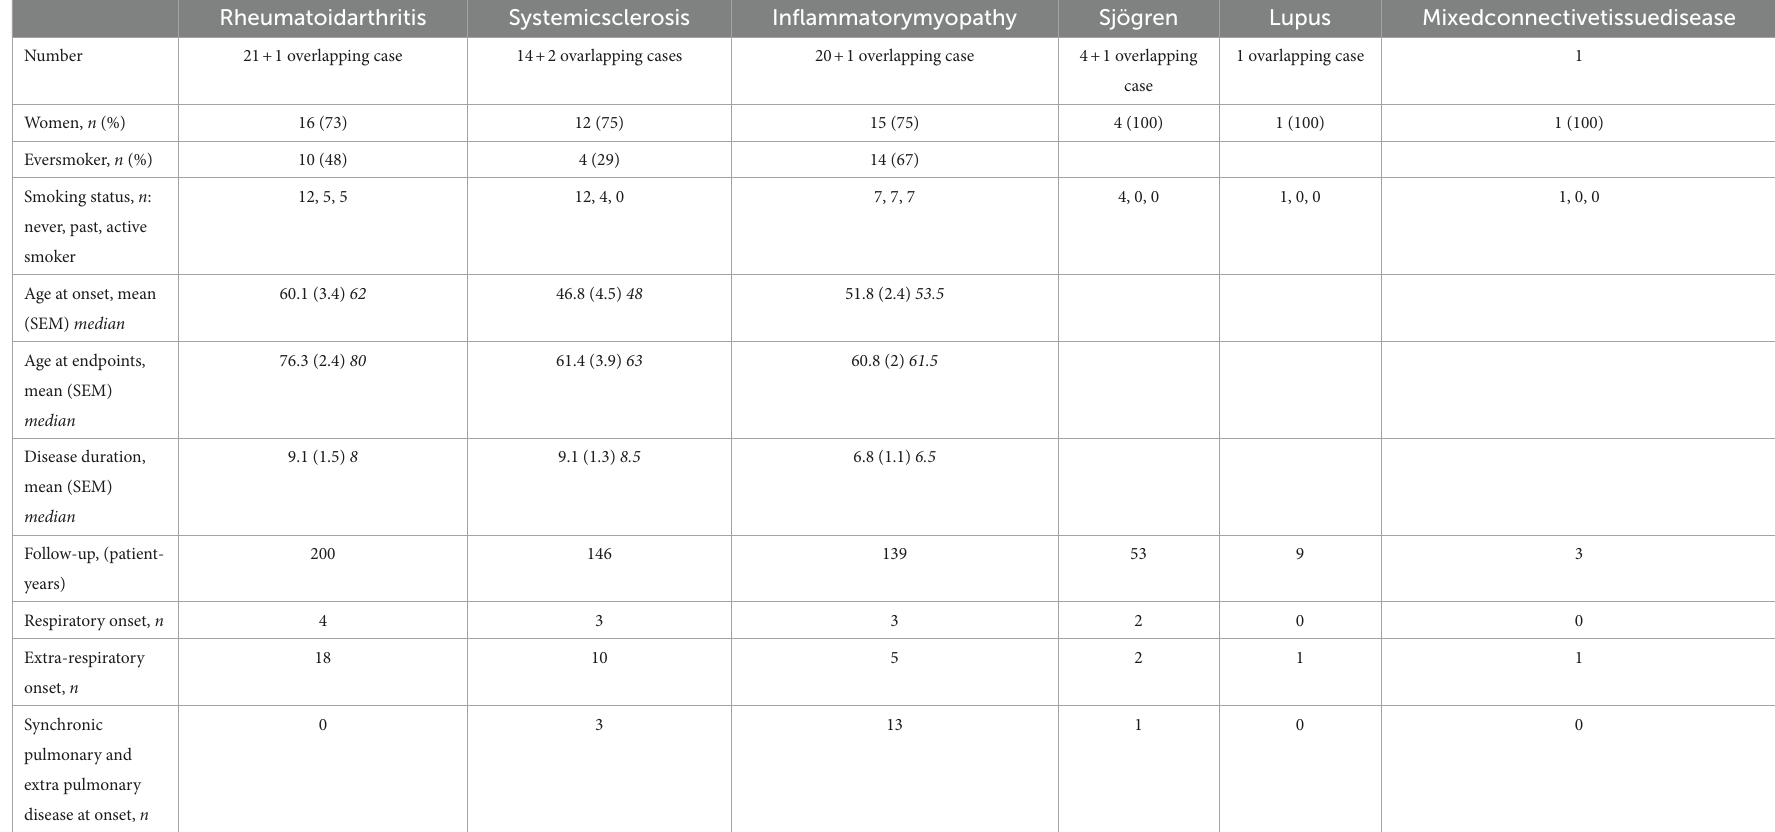
TABLE 2 CTD-IP cases. Patients are allocated according to fulfillment of classification criteria for the different connective tissue diseases (CTD) at the end of follow-up.